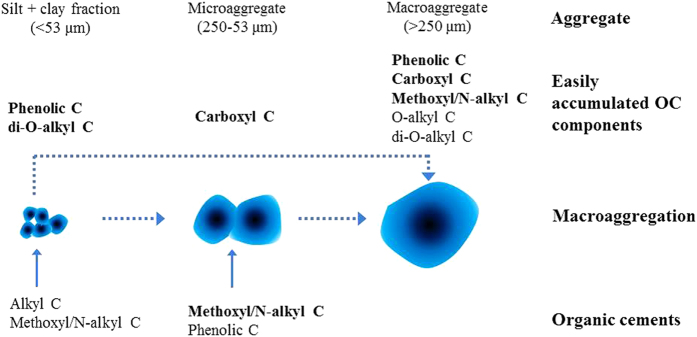
Schematic overview of macroaggregation and OC accumulation mechanisms in aggregates.The dotted arrows indicate the formation of macroaggregate and the solid arrows show the organic cements in microaggregates and the silt + clay fractions.